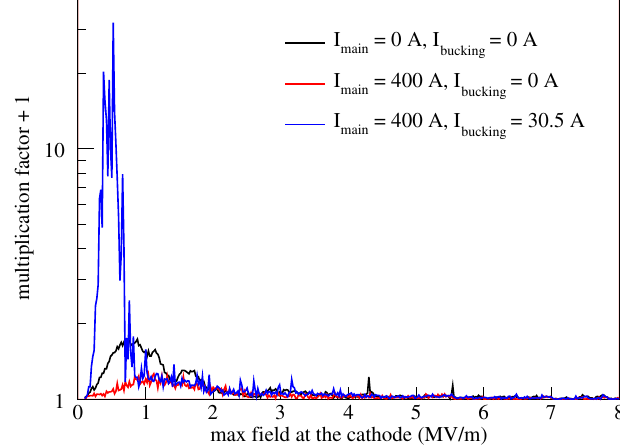
FIG. 18. (Color) Multiplication factor after 140 rf cycles as a function of the maximum field at the cathode for the PITZ gun. Three combinations of main and bucking solenoids currents are shown; 1 is added to the multiplication factor for better visual- ization on a logarithmic